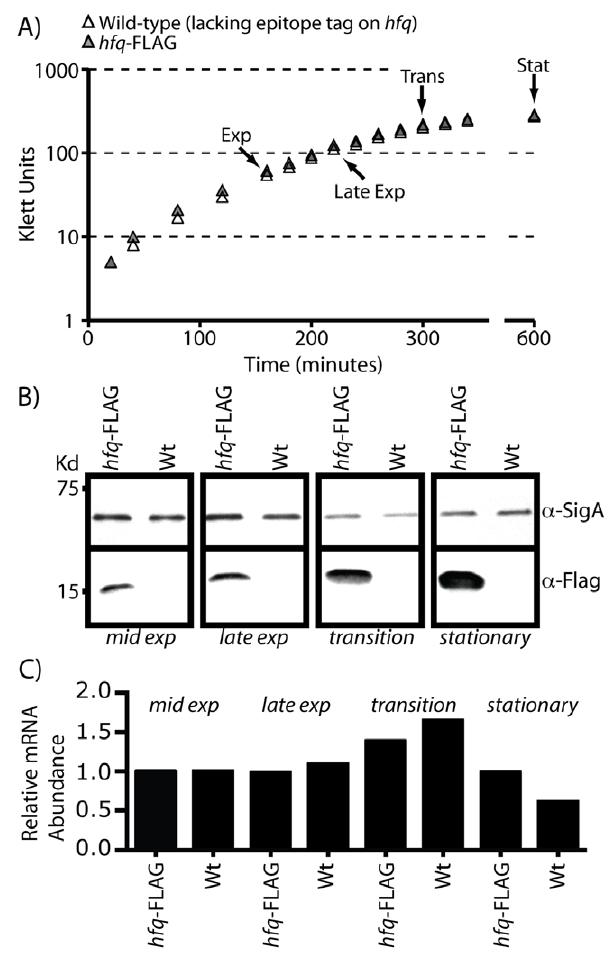
Figure 1. Expression of hfq in B. subtilis . Growth of wild-type B. subtilis 168 and hfq FLAG in minimal medium. Cell density was measured at 20 minute intervals using a Klett meter. Arrows denote the time points where samples were collected for analysis by Western blotting and quantitative real-time RT-PCR (qPCR). (B) Whole cell lysates were resolved on a 4–20% SDS-PAGE gel and transferred to a nitrocellulose membrane. Hfq FLAG was detected using a -FLAG mono- clonal antibody and visualized by chemiluminescence. The blots were stripped and re-probed with a -Sigma A rabbit serum as a loading control. (C) Measurement of hfq transcript abundance by qPCR. The experimentally determined C t values were normalized both to the corresponding value obtained at mid exponential phase and to that of sigA . Values are reported as the fold change in expression, relative to mid-exponential growth